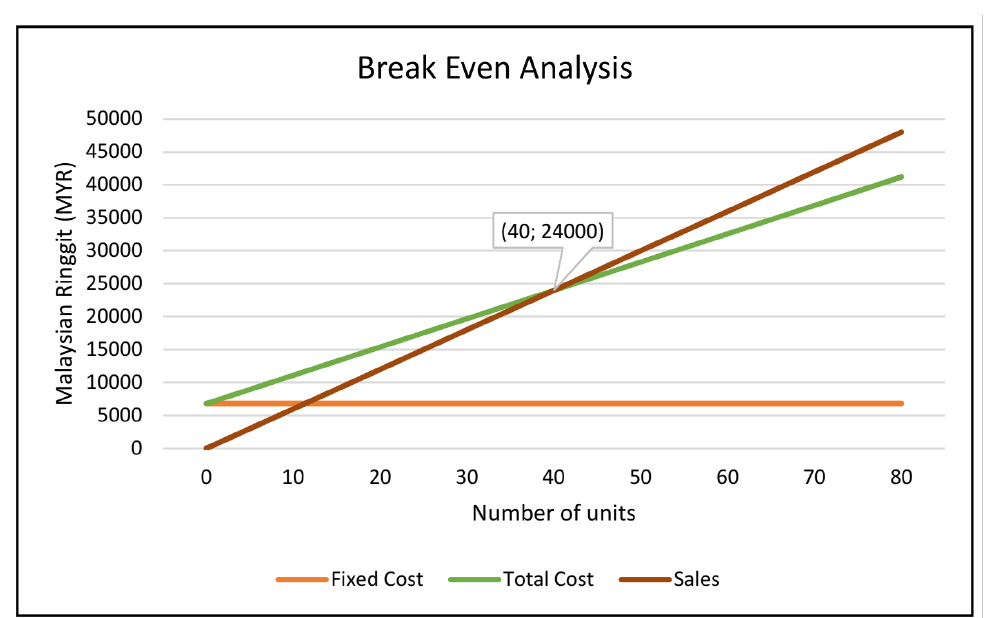
Figure 20. Break-even analysis